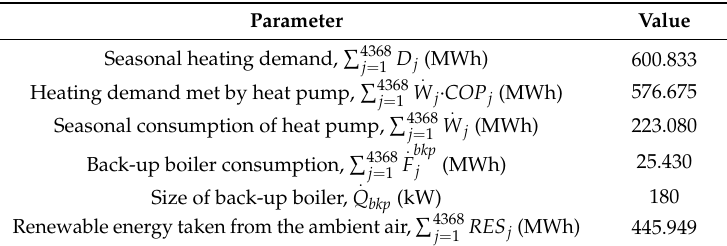
Table 7. Energy results in the baseline case.